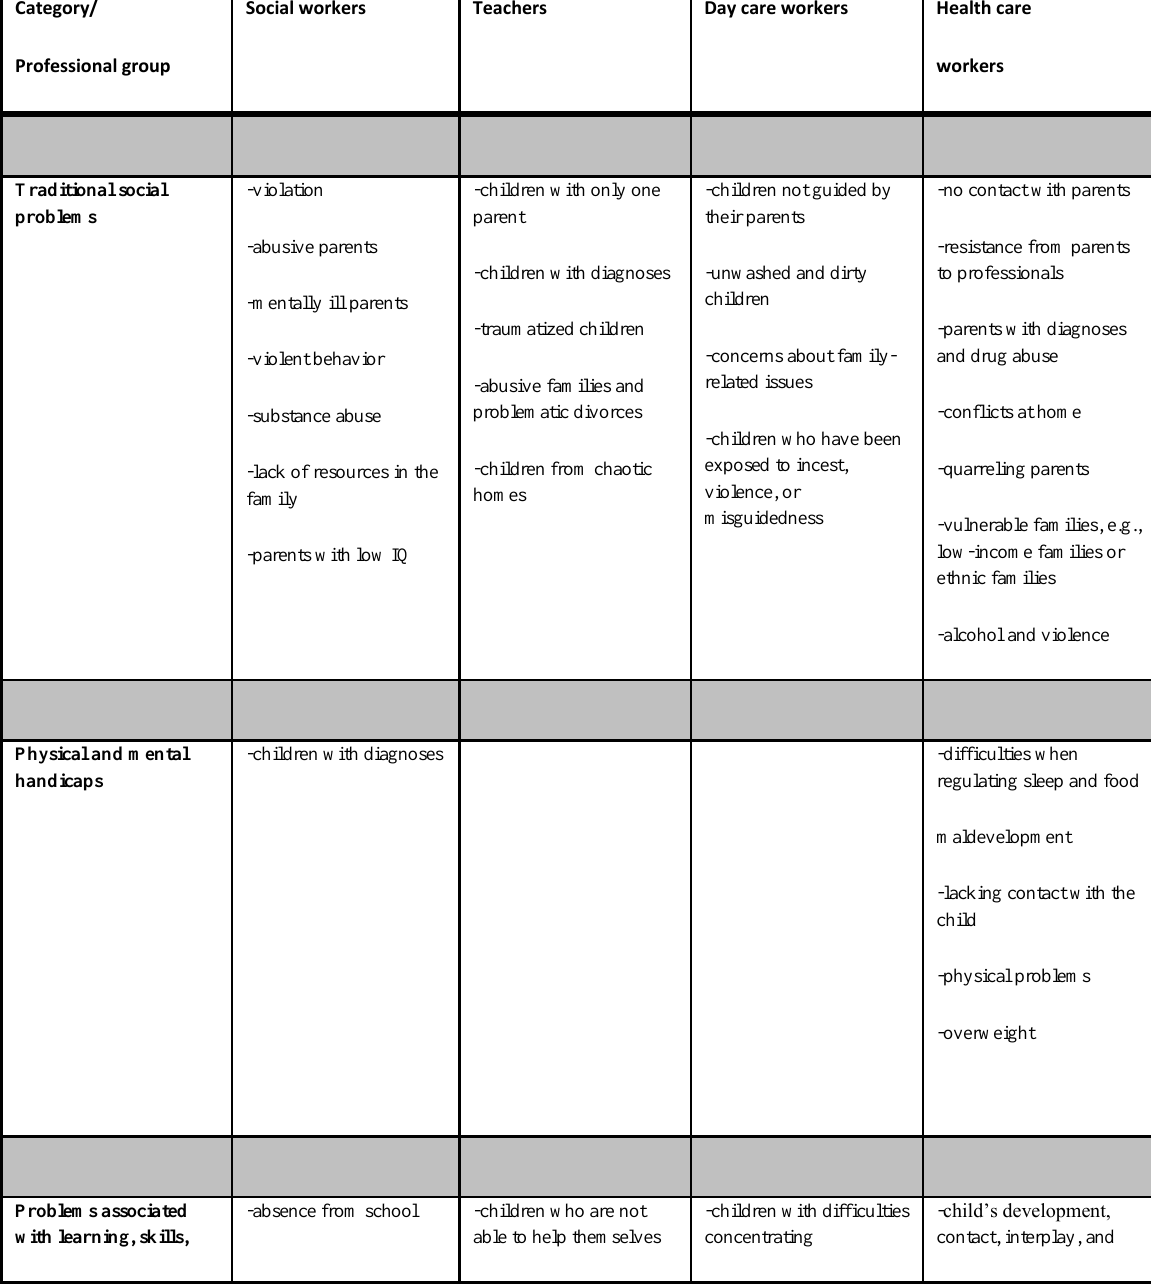
Table 1: Categorization (Theilmann & Laursen,